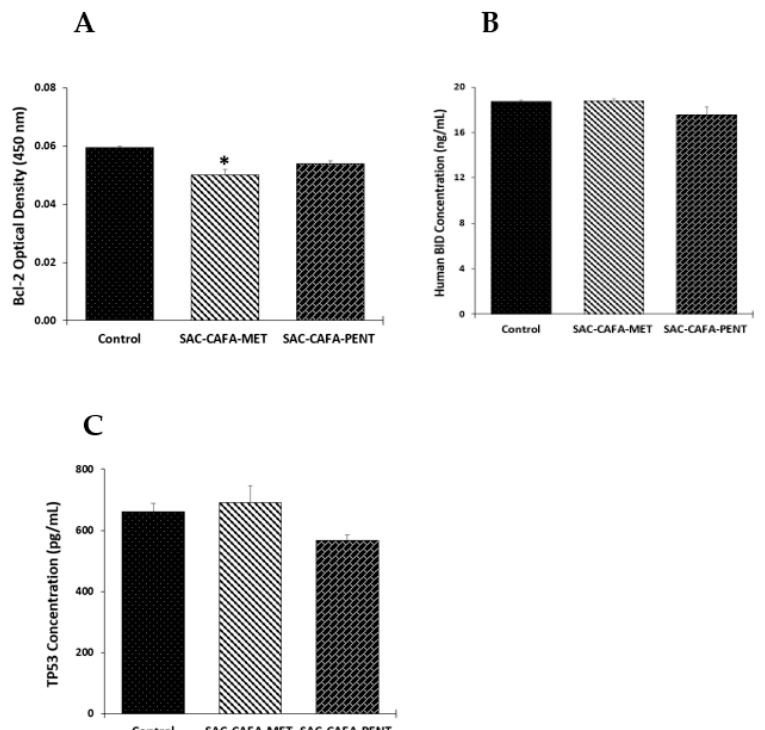
Figure 3. Levels of apoptotic biomarkers in SW480 cells 48 h post-treatment with hybrids SAC-CAFA-MET (124.2 µM) and SAC-CAFA-PENT (118 µM) or 1% DMSO (control): ( A ) Level of anti-apoptotic Bcl-2 protein. ( B ) Level of human bid protein. ( C ) Level of tumor-suppressor protein p53. Data are presented as the mean ± SE of three independent experiments (* p < 0.05). Optical density is directly proportional to the quantity of the protein.